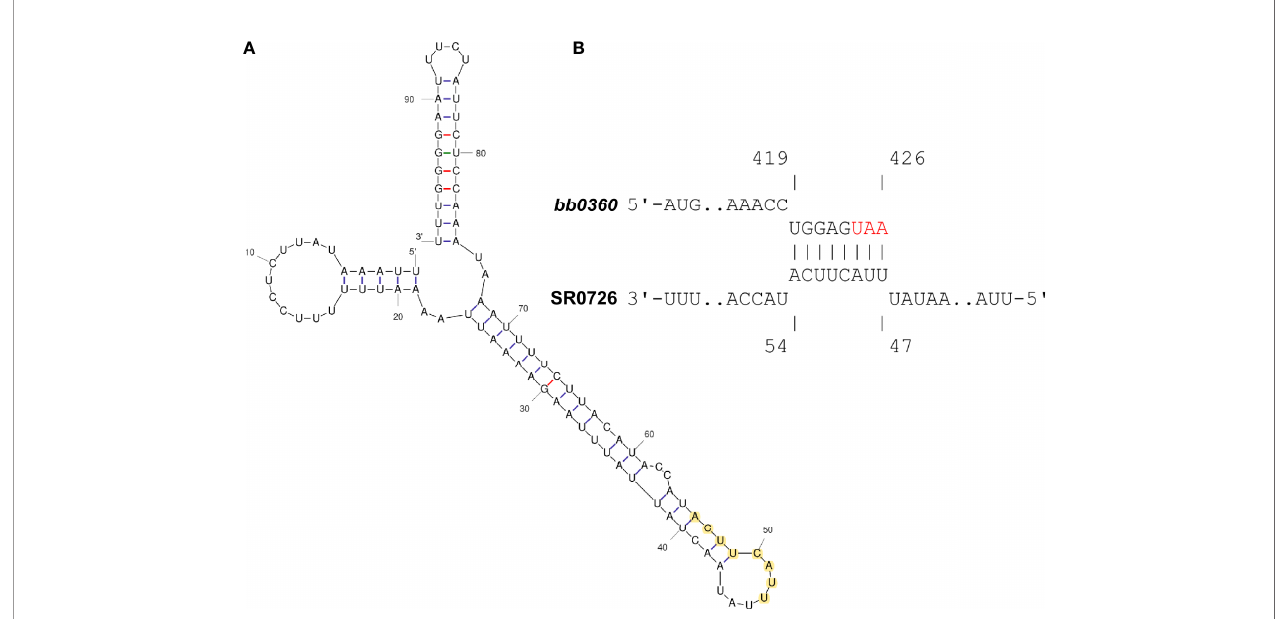
FIGURE 8 | In silico analysis predicts potential interaction between SR0726 and 3 ’ terminus of bb0360 mRNA. (A) Predicted secondary structure of putative SR0726 RNA generated in mfold. (B) Potential interaction of SR0726 (lower) within the coding sequence of bb0360 (upper) generated in intaRNA. Red letters indicate the bb0360 stop codon. Nucleotides predicted to participate in the interaction are highlighted in yellow on the predicted SR0726